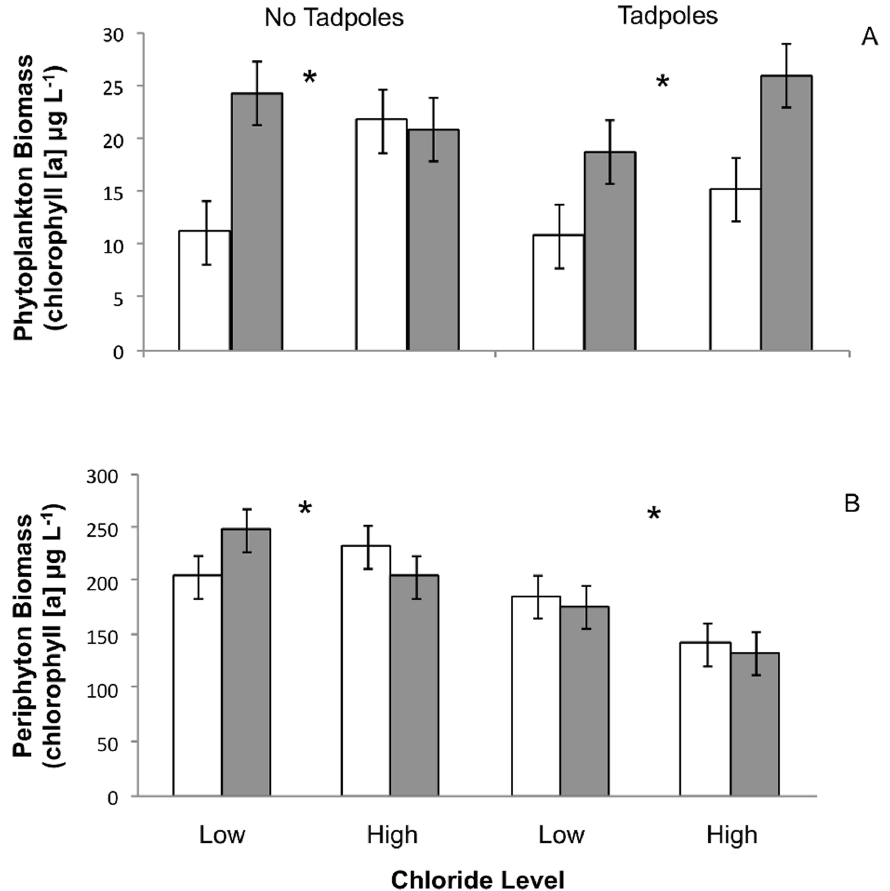
Figure 1. Mean phytoplankton (A) and periphyton (B) biomass (measured as chlorophyll [a] concentration in m g L 2 1 ) across chloride (low/high), tadpole (absent/present) and pond inoculum conductance level (low/high) treatments (n=5 per treatment combination) over the duration of the study. Open bars represent low pond inoculum conductance levels and shaded bars represent high pond inoculum conductance levels. Asterisks indicate a statistically significant difference (p , 0.05) between low and high chloride treatments using RMANOVA. Error bars represent standard error. (Table S4). We did not identify ostracods or copepod nauplii (juveniles) beyond order. The zooplankton community in the high chloride treatment was dominated (93% of total zooplankton) by the rotifer family Brachionidae (3586 individuals belonging to family Brachionidae out of 3853 total zooplankton individuals counted in the high chloride treatment) (Fig. 2). Within this family, Brachionus plicatilus , a species common to salt and brackish waters [41], was the most abundant (data not shown). In contrast, the Brachionidae only accounted for 27% of total zooplankton community composition in the low chloride treatment (103 individuals belonging to family Brachionidae out of 379 total zooplankton individuals counted in the low chloride treatment). Ostracods, cladocerans, copepod adults and nauplii and other rotifers were much more abundant in the low chloride treatment relative to the high chloride treatment (Fig. 2).